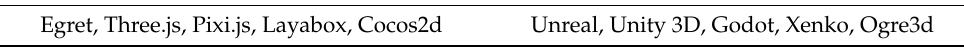
Table 1. Mainstream engine. Web3d Engine Game